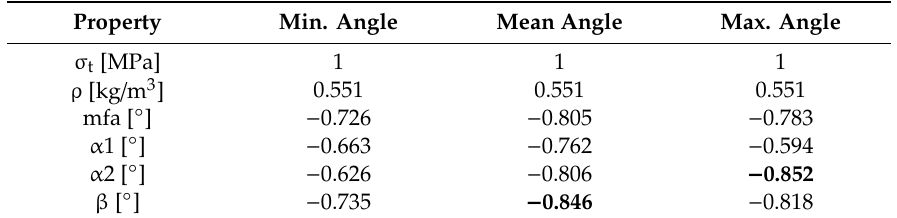
Table 2. Pearson correlation of the relevant properties’ density, minimum, mean, and maximum α 1, α 2 and mfa with the ultimate tensile strength of n = 18 samples.